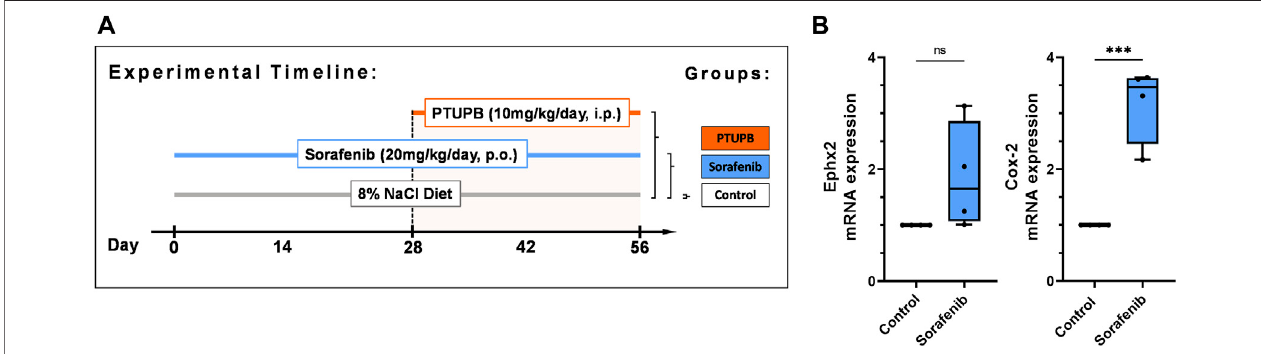
FIGURE 1 | Overview. Timeline showing the experimental design (A) . Expression of soluble epoxide hydrolase enzyme (Ephx2) and cycolooxygenase-2 (COX-2) sorafenibtreatment (B) .( n (cid:1) 4 – 6rats/group,Dotsrepresent theaverageofduplicatemeasuresforeach individualrat.ns p > 0.05,*** p ≤ 0.001determinedbyStudent ’ s t-test. Data are reported as box and whisker plots with median, minimum to maximum, and 10 to 90